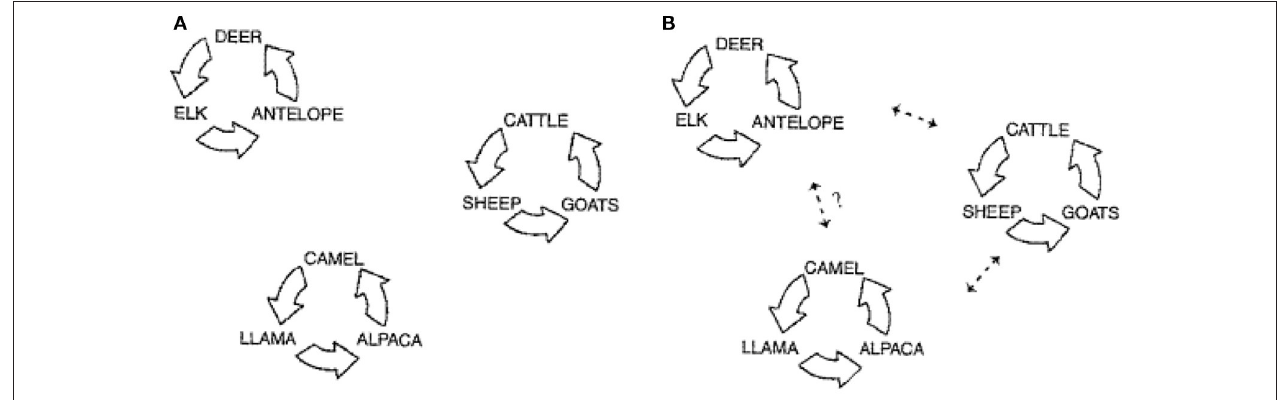
FIGURE 1 | Schematic depicting the three population groupings for pestivirus infections. (A) Represents the circulation of the virus infection within three distinct main host clusters: wildlife, domestic livestock, and camelids. (B) Represents the documented spread of virus between these clusters, and the potential for transmission between the camelid cluster and wildlife cluster (modified from Evermann,